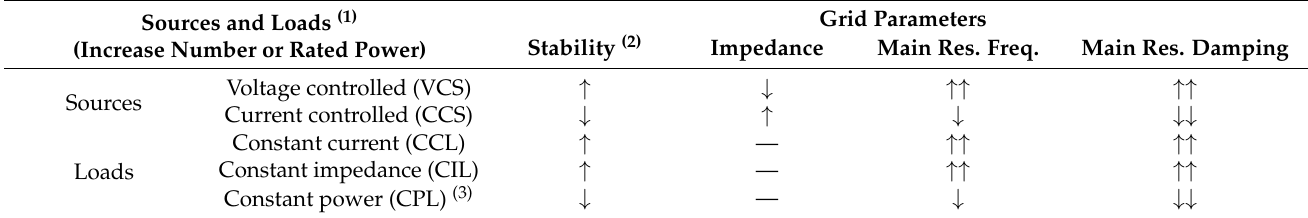
Table 1. Summary of effect of sources and loads (and their number) on DC microgrid main resonance [29]. Sources and Loads